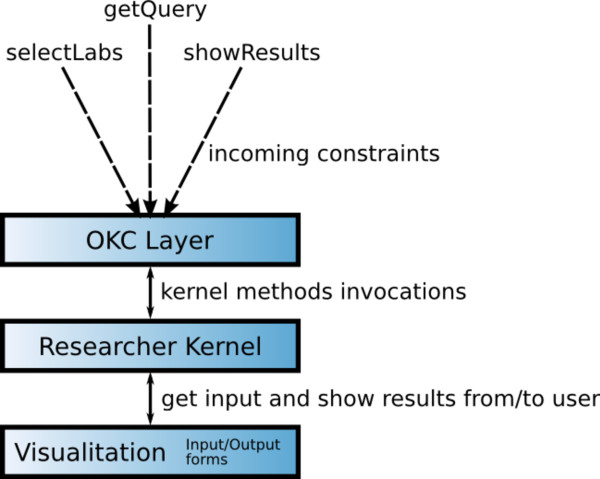
Schematic view of the researcher OKC architecture.